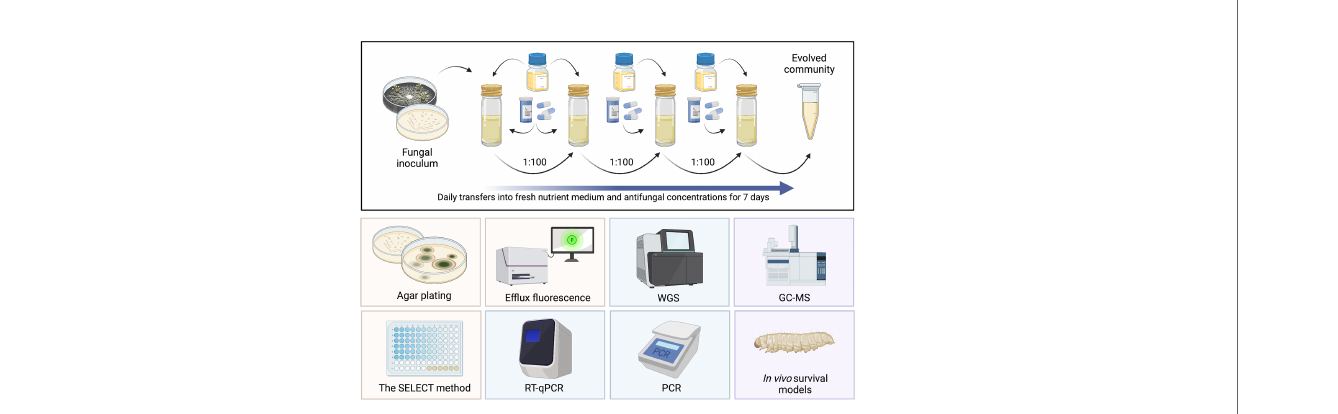
FIGURE 4 | Summary of proposed assays to generate antifungal MSC data. Top: serial culture of a fungal community exposed to different antifungal concentrations for a period of 7 days, with daily transfers into fresh nutrient medium and antifungal concentrations. Yellow: phenotypic methods, blue: genotypic methods, purple: methods requiring further investigation. RT-qPCR, reverse transcription quantitative polymerase chain reaction; WGS, whole genome sequencing; PCR, polymerase chain reaction; GC-MS, gas chromatography mass spectroscopy. Created